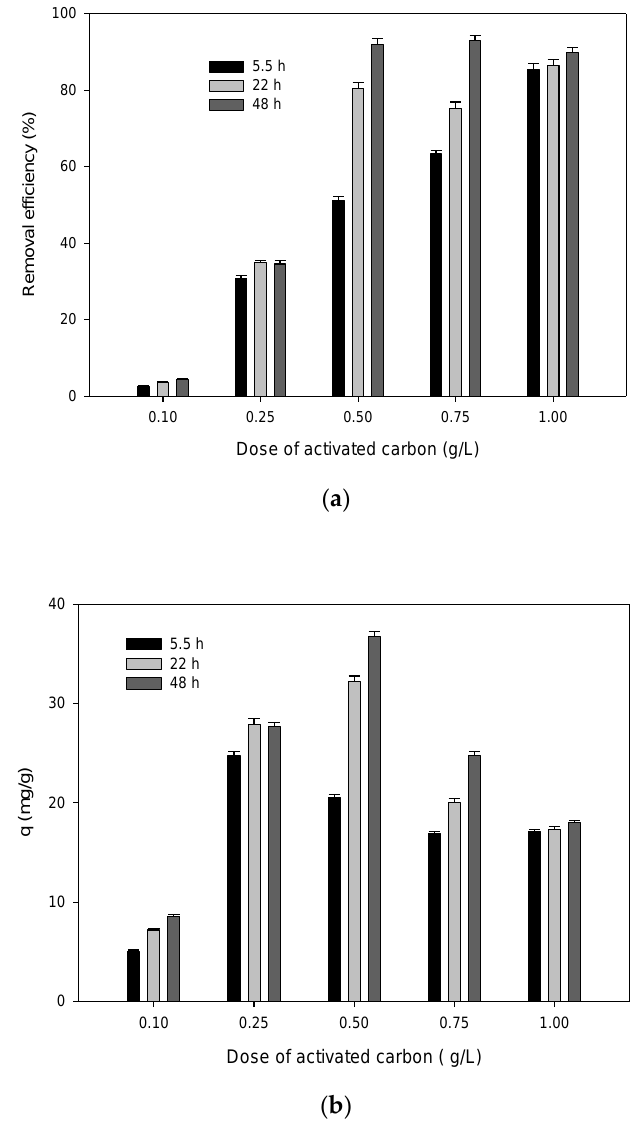
Figure 3. ( a ) BPA removal efficiency and ( b ) amount of BPA adsorbed by gram of activated carbon depending on adsorbent dosage at different contact times.